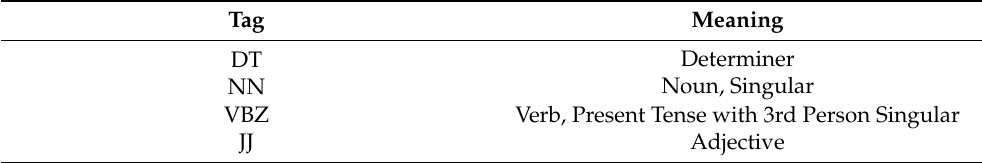
Table 2. The meanings of